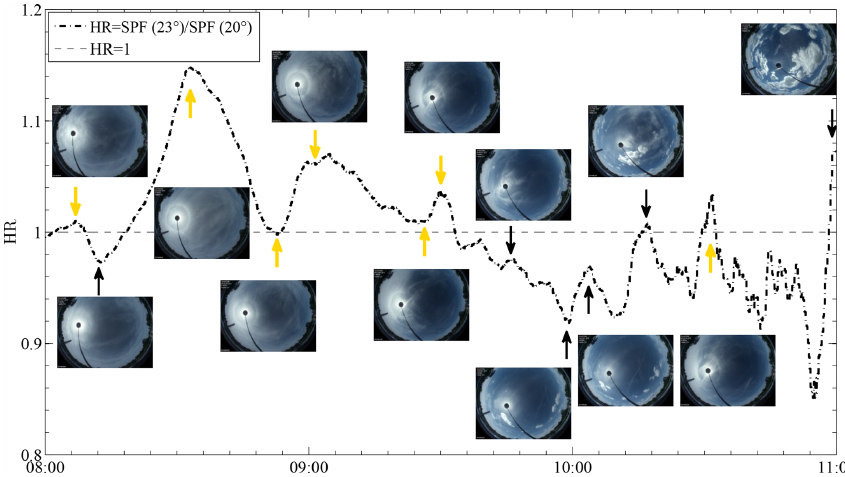
Figure 10. HR time series from 6 July 2016 between 08:00 and 11:00. All-sky images corresponding to peaks and dips are also shown. Yellow arrows indicate the presence of relatively bright halo, while black ones indicate either the presence of faint halo or the absence of it.